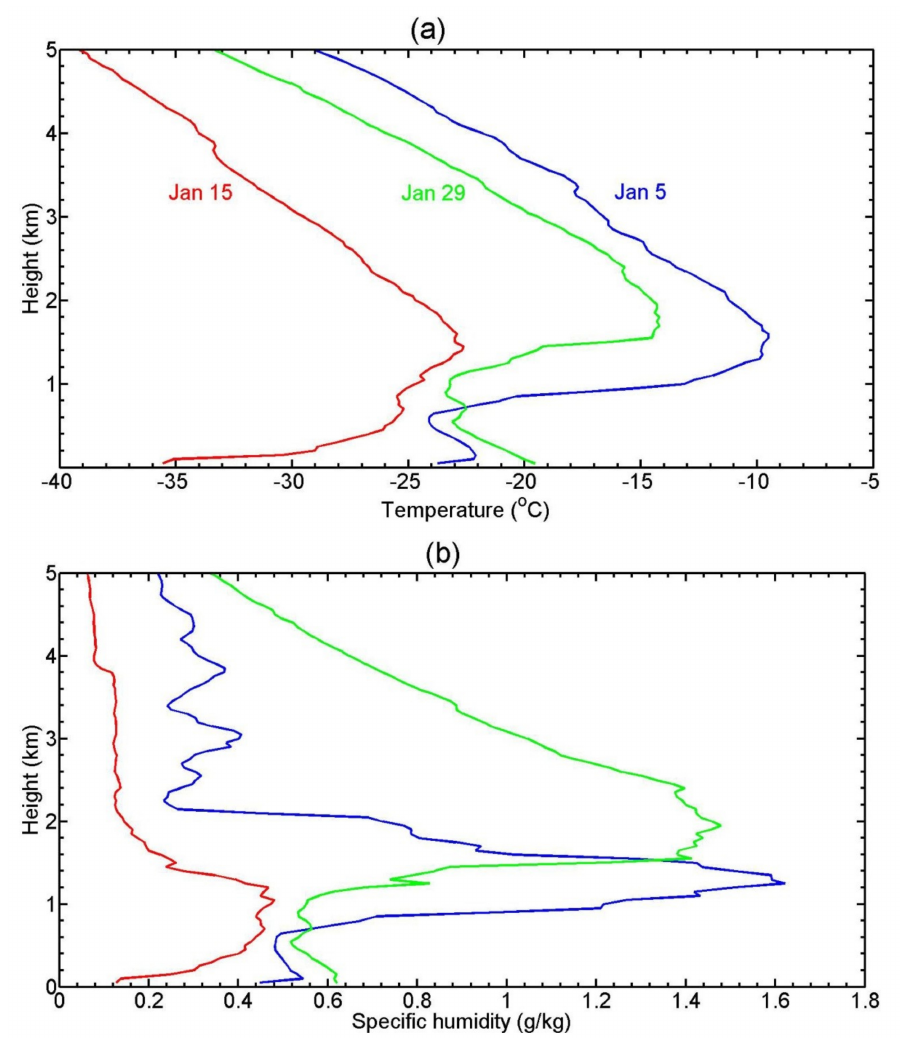
Figure 3. The SHEBA radiosonde profiles of temperature ( ◦ C) ( a ) and specific humidity (g / kg) ( b ) for three days in January